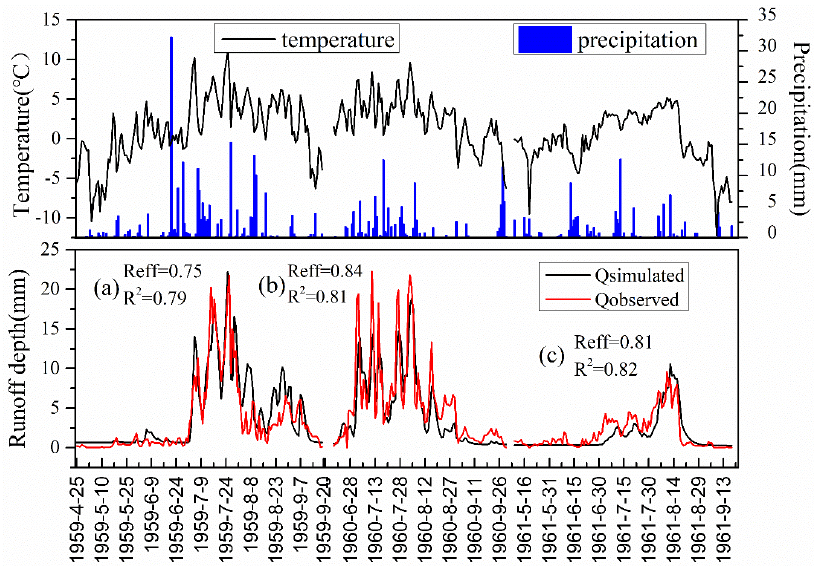
Figure 6. Observed precipitation, temperature, and runoff depth and simulated runoff depth. (Calibration periods from 1959 to 1961).